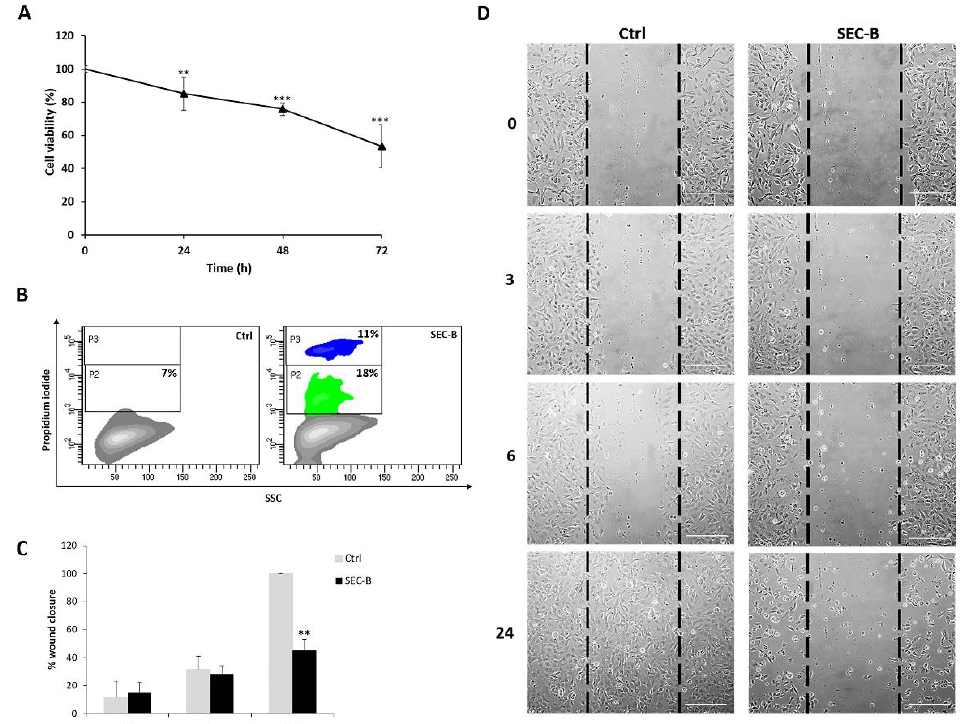
Figure 1. Effect of SEC-B on endothelial cell viability and proliferation. ( A ) Cell viability evaluation by WST-8 colorimetric assay upon 20 µ M SEC-B administration for 24 h, 48 h and 72 h. ( B ) Representative supravital PI contour plots of treated HMEC-1 at 72 h showing apoptotic (green) and necrotic (blue) populations in HMEC-1-treated cells. ( C ) Quantitative analysis of the wound healing assay performed at 3 h, 6 h and 24 h after 20 µM SEC-B administration. Data are expressed as mean ± SD ( n = 3). ** p < 0.01; *** p < 0.001 vs. untreated cells. ( D ) Representative images of the wound healing assay performed at 3 h, 6 h and 24 h after 20 µM SEC-B administration, as obtained by optical microscopy using the 10× objective. Scale bar: 200 µm.